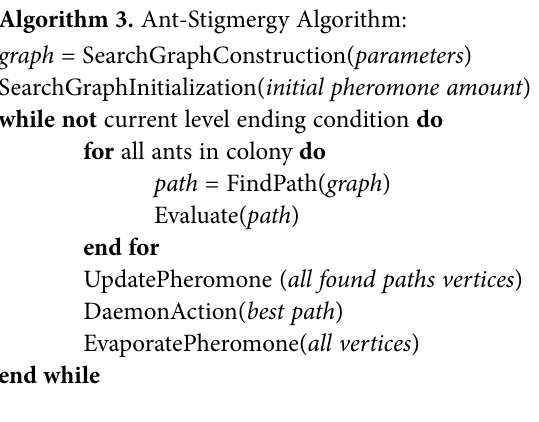
Algorithm 3. Ant-Stigmergy Algorithm: graph = SearchGraphConstruction( parameters ) SearchGraphInitialization( initial pheromone amount )